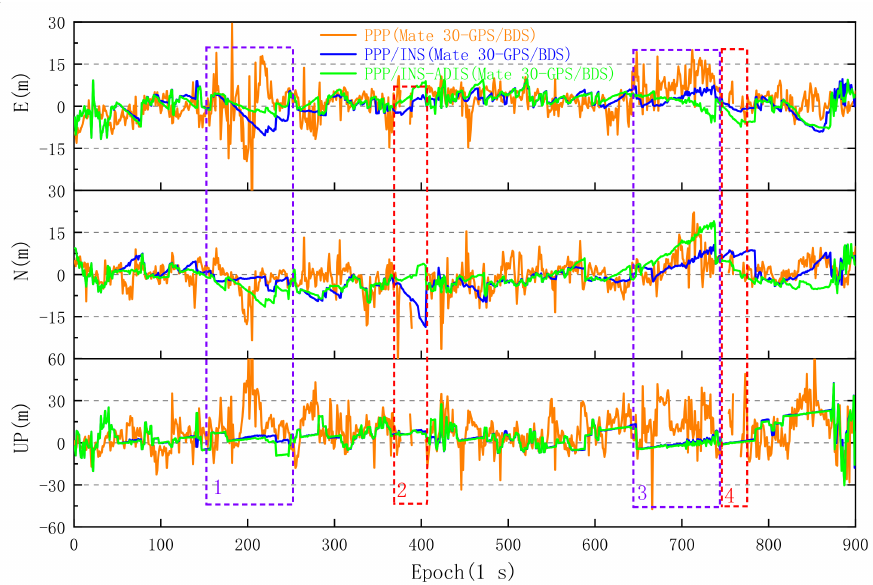
Figure 17. Comparison of Huawei Mate 30 GPS/BDS PPP, PPP/INS, and PPP/INS–ADIS solutions with reference points. The boxes 1, 2, 3, and 4 corresponds to the boxes in Figure 16.